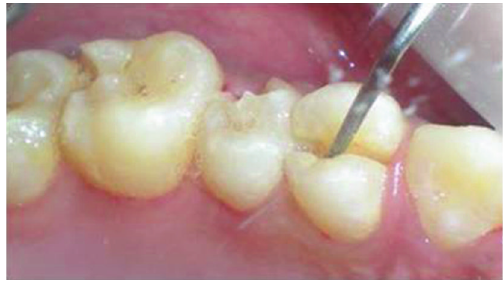
Figure 6: Preoperative radiograph revealing oblique root fracture with 24, loss of buccal cusp with 25, and oblique fracture of distobuccal cusp with